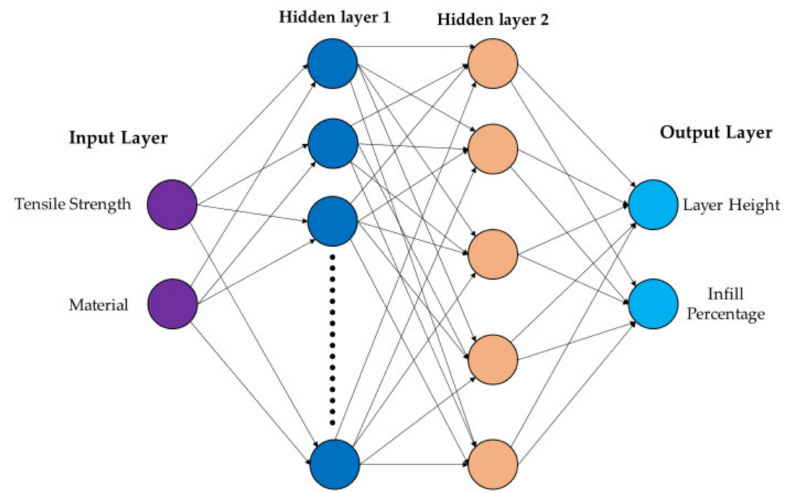
Figure 9. Trained MLP model